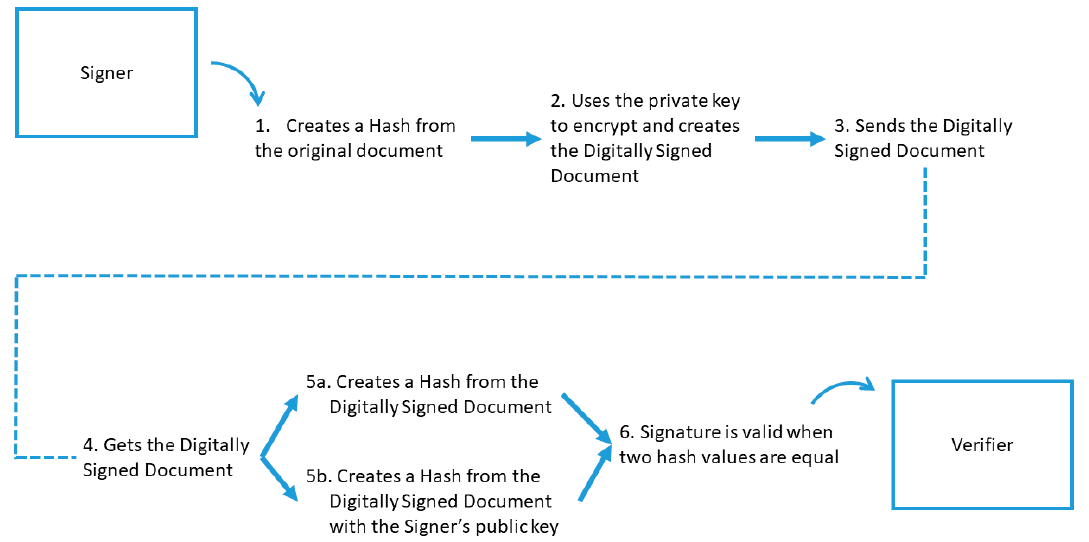
Figure 10. Descriptive overview of Signed Message pattern (https://medium.com/@meruja/digital-signature-generation- 75cc63b7e1b4 (accessed on 2 December 2020)).